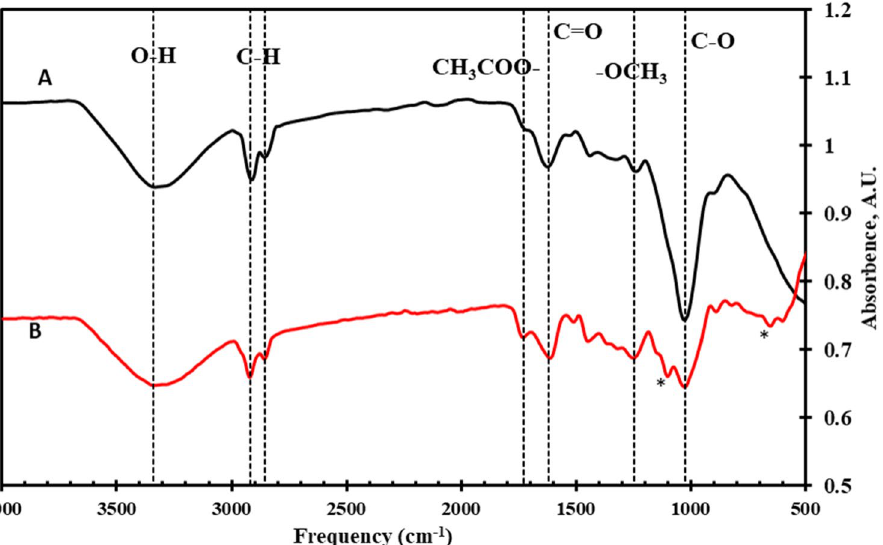
Figure 4. FTIR spectra for ( A ) raw DPF and ( B ) C8-DPF. Additional peaks appear after the C8 modification indicated with the *